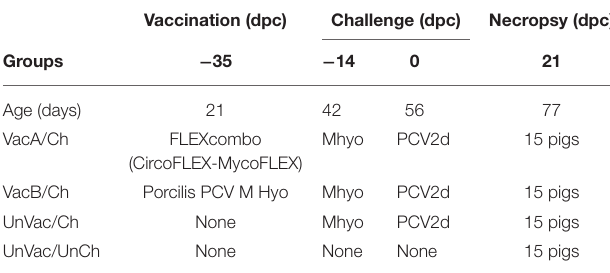
Different letters mean statistically significant differences within 5 groups (P <